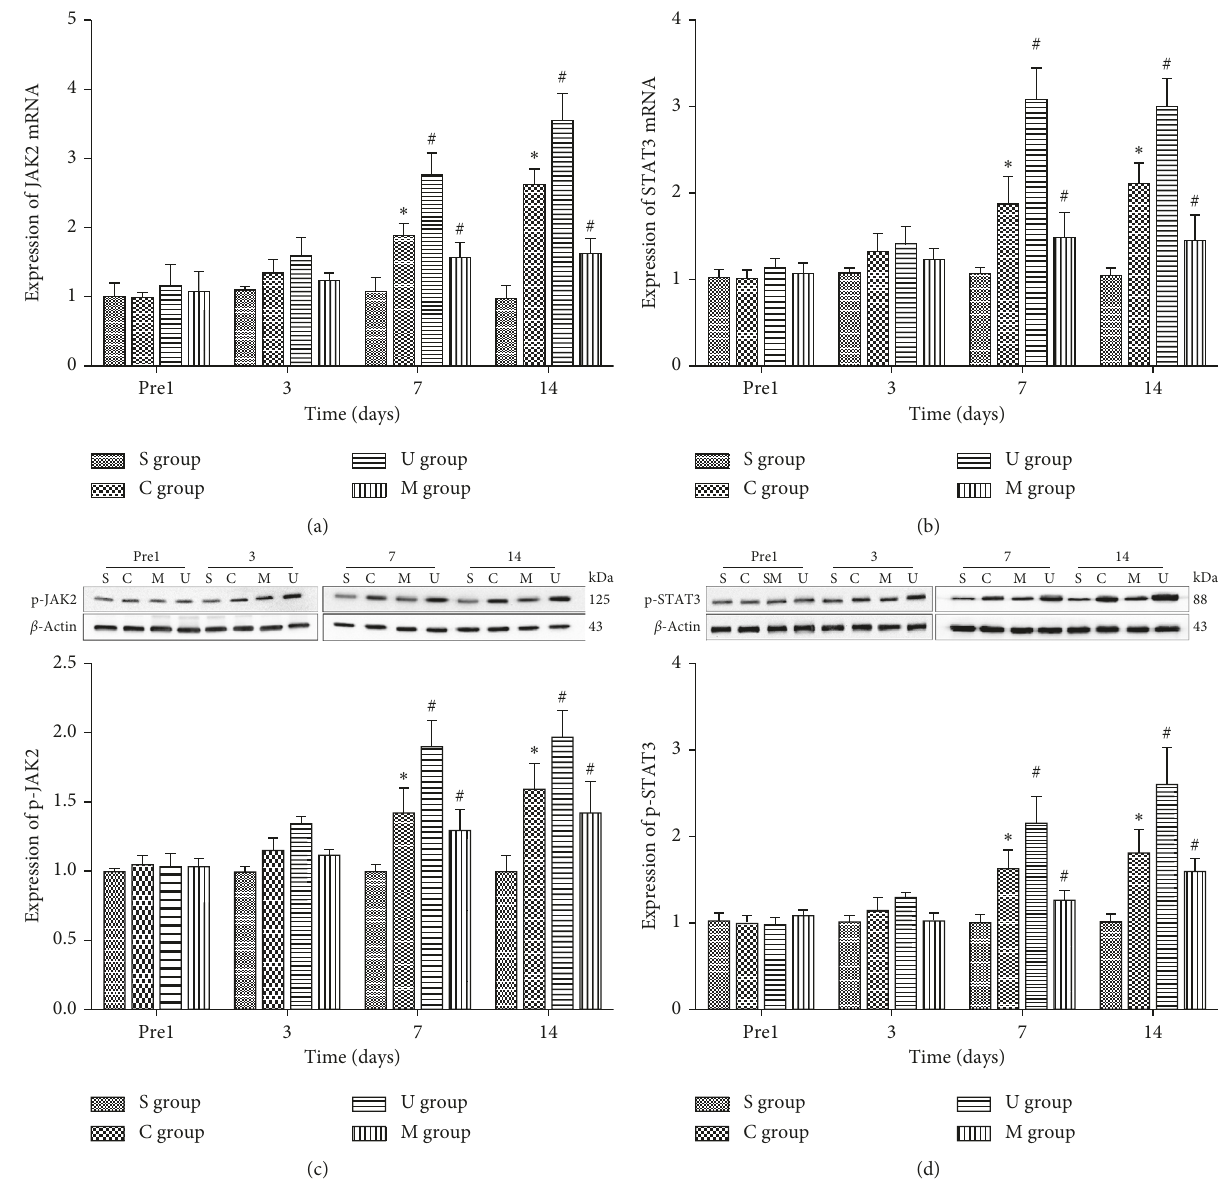
Figure 4: The JAK/STATsignaling pathway was activated in CCI model rats. The mRNA levels of JAK2 (a) and STAT3 (b) were shown with mean ± SEM of IOD of JAK2/ β -actin and STAT3/ β -actin in all rats, n � 5; the phosphorylated JAK2 (p-JAK2) (c) and STAT3 (p-STAT3) (d) levels were shown by the western blot and quantified by mean ± SEM of IOD of p-JAK2/ β -actin and p-STAT3/ β -actin in all rats, n � 5, respectively. S: sham-operated rats; S: CCI rats; M: CCI rats treated with MRS2578; U: CCI rats treated with UDP. Comparisons of JAK2/ STAT3 proteins and mRNA among four groups were analyzed with two-way ANOVA followed by Holm–Sidak post hoc analysis ( ∗ P < 0 . 05, vs the sham group; # P < 0 . 05, vs the CCI